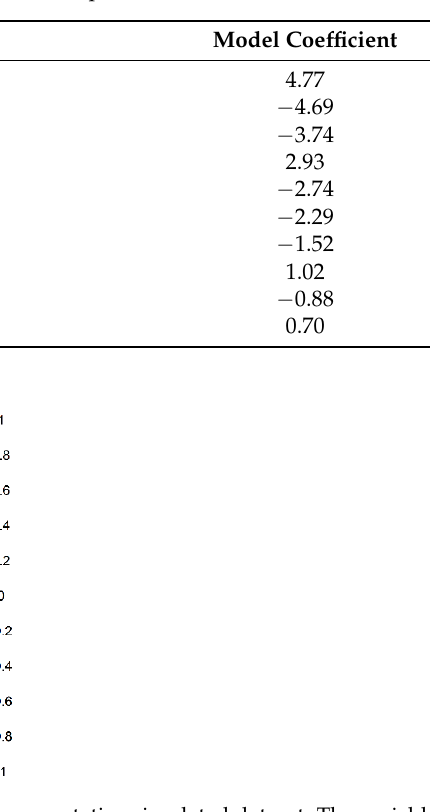
Table 1. Coefficients of the true Cox model for the representative simulated dataset.